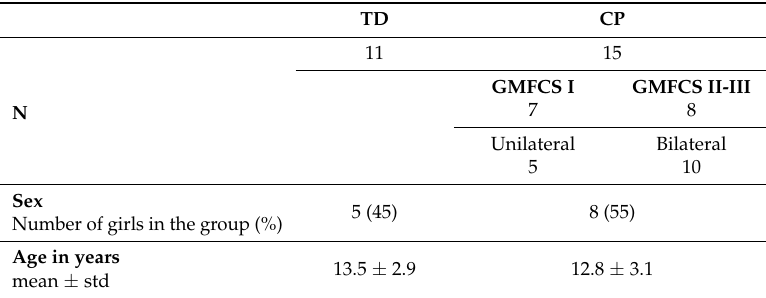
Table 2. General characteristics of the study